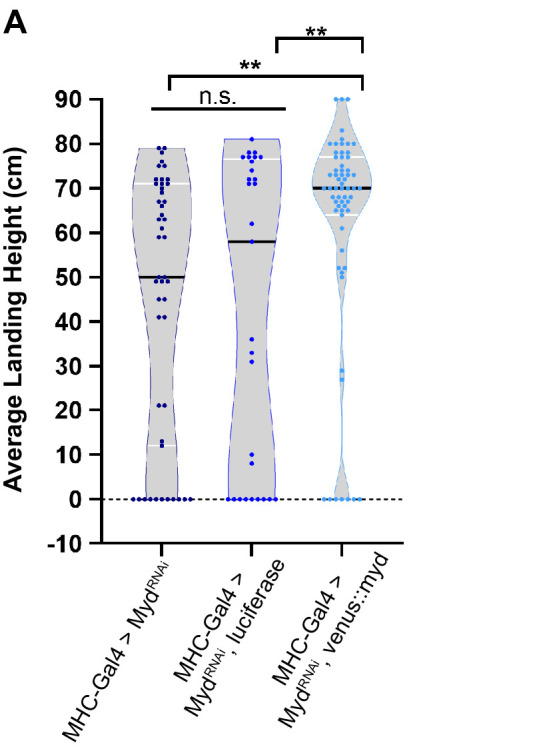
Validation of UAS-mydRNAi transgene.Landing height of flies upon muscle-specific knockdown of myd using UAS-mydRNAi. Flight defect from RNAi is rescued by co-expression of UAS-Venus::Myd, but not by UAS-luciferase. Black bars represent median values. The landing average (cm) and sample size (n) for each condition are: MHC-Gal4 > mydRNAi44.5 cm, n = 47, MHC-Gal4 > mydRNAi, luciferase 42.0 cm, n = 29, and MHC-Gal4 > mydRNAi, venus::myd 62.0 cm, n = 63. **, p-value<0.01 using a one-way ANOVA with Turkey Post hoc multiple comparisons. N.S. = Not Significant.
Figure 4—figure supplement 1—source data 1.Raw data for Figure 4—figure supplement 1.